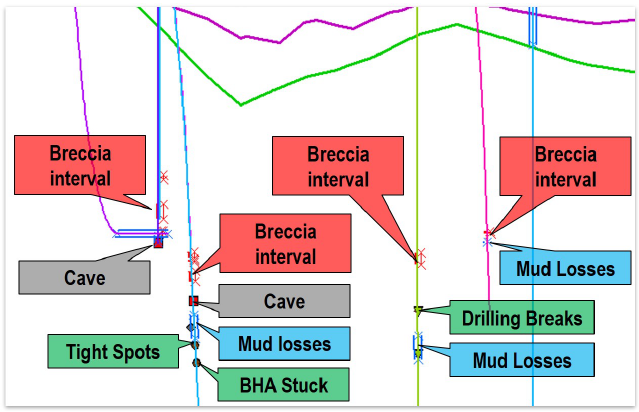
Figure 2. Drilling events in the karstification intervals.